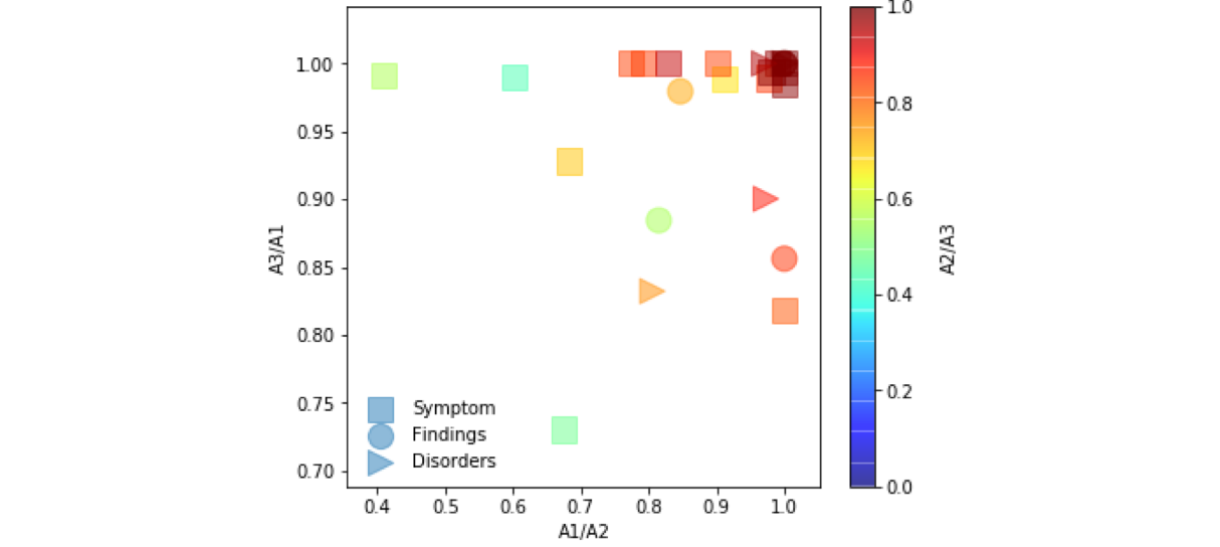
Figure 1. Pairwise interannotator agreement according to semantic category for each queried